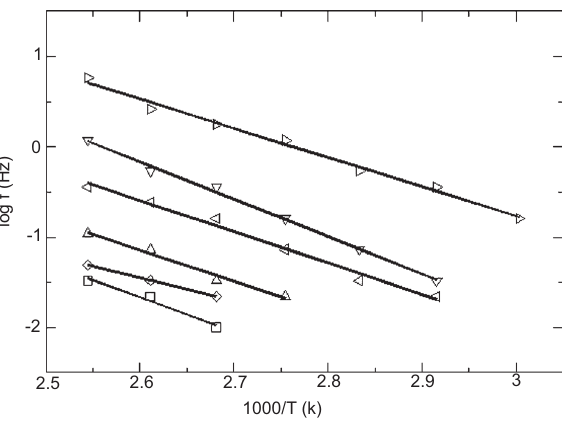
Figure 11 Plot of log f versus 1/ T for MWS relaxation: □ PS+5% GTR; ◊ PS+10% GTR;  PS+20% GTR;  PS+40% GTR;  PS+50% GTR;  PS+70%